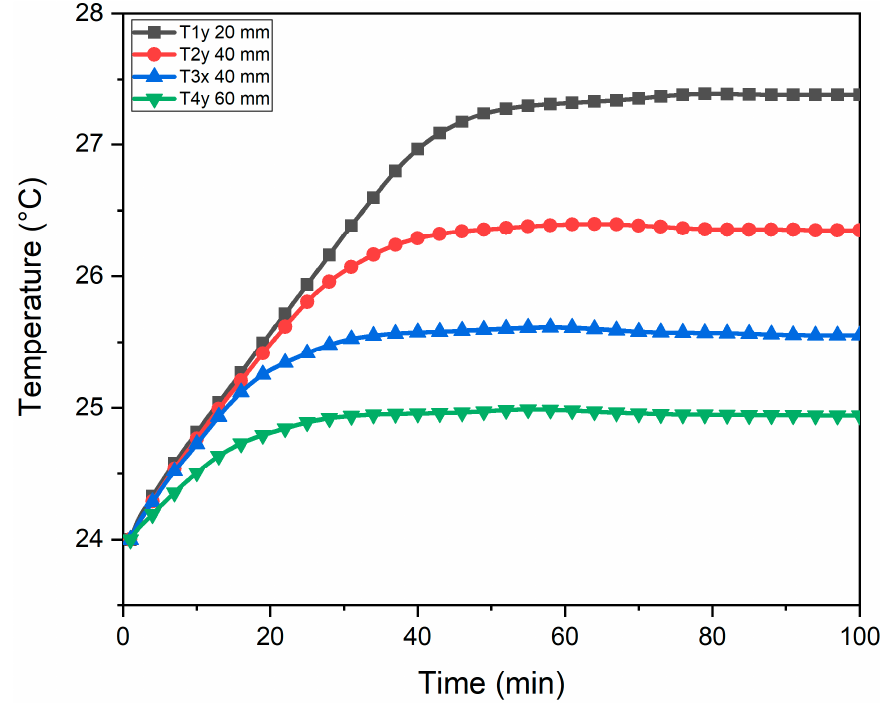
Figure 7. Temperature profile along the x - and y -axis for crossflow configuration with 10 W power input.